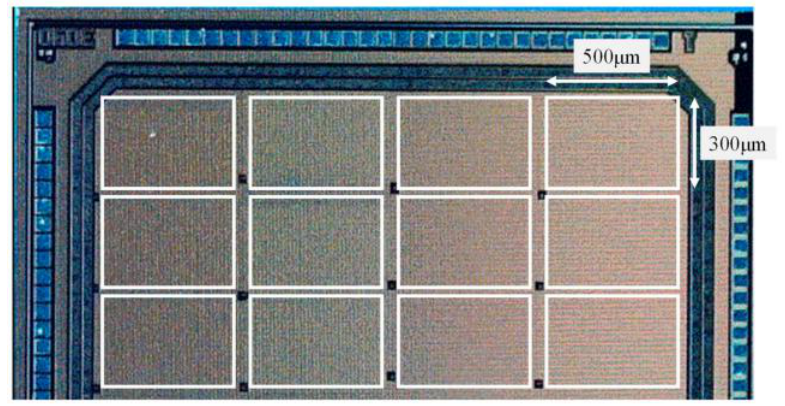
Figure 10. Die photo.